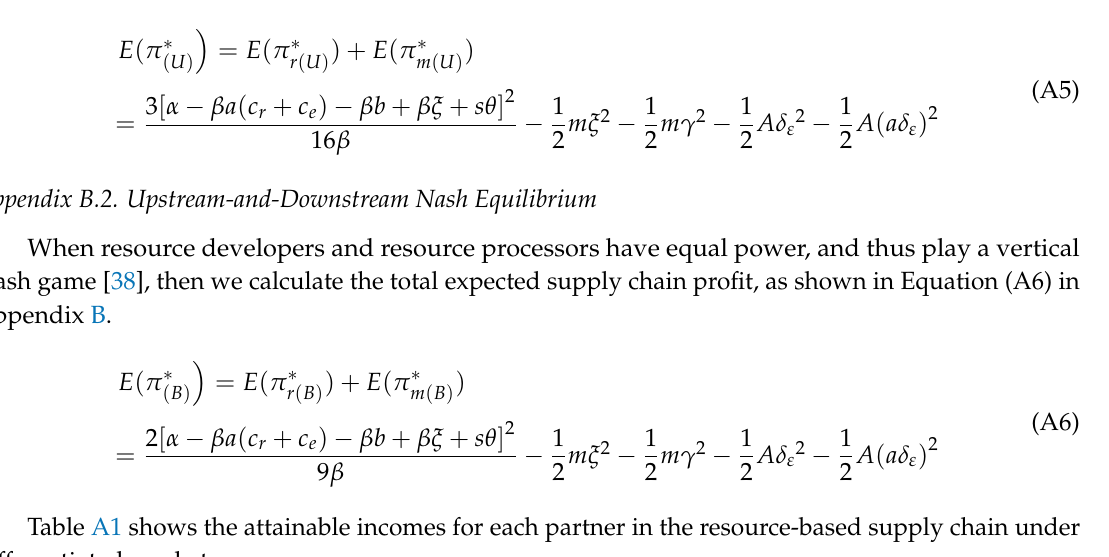
Table A1. Equilibrium and incomes for the resource-based supply chain under differentiated markets. Participators Resource Developer Resource Processor Downstream leading